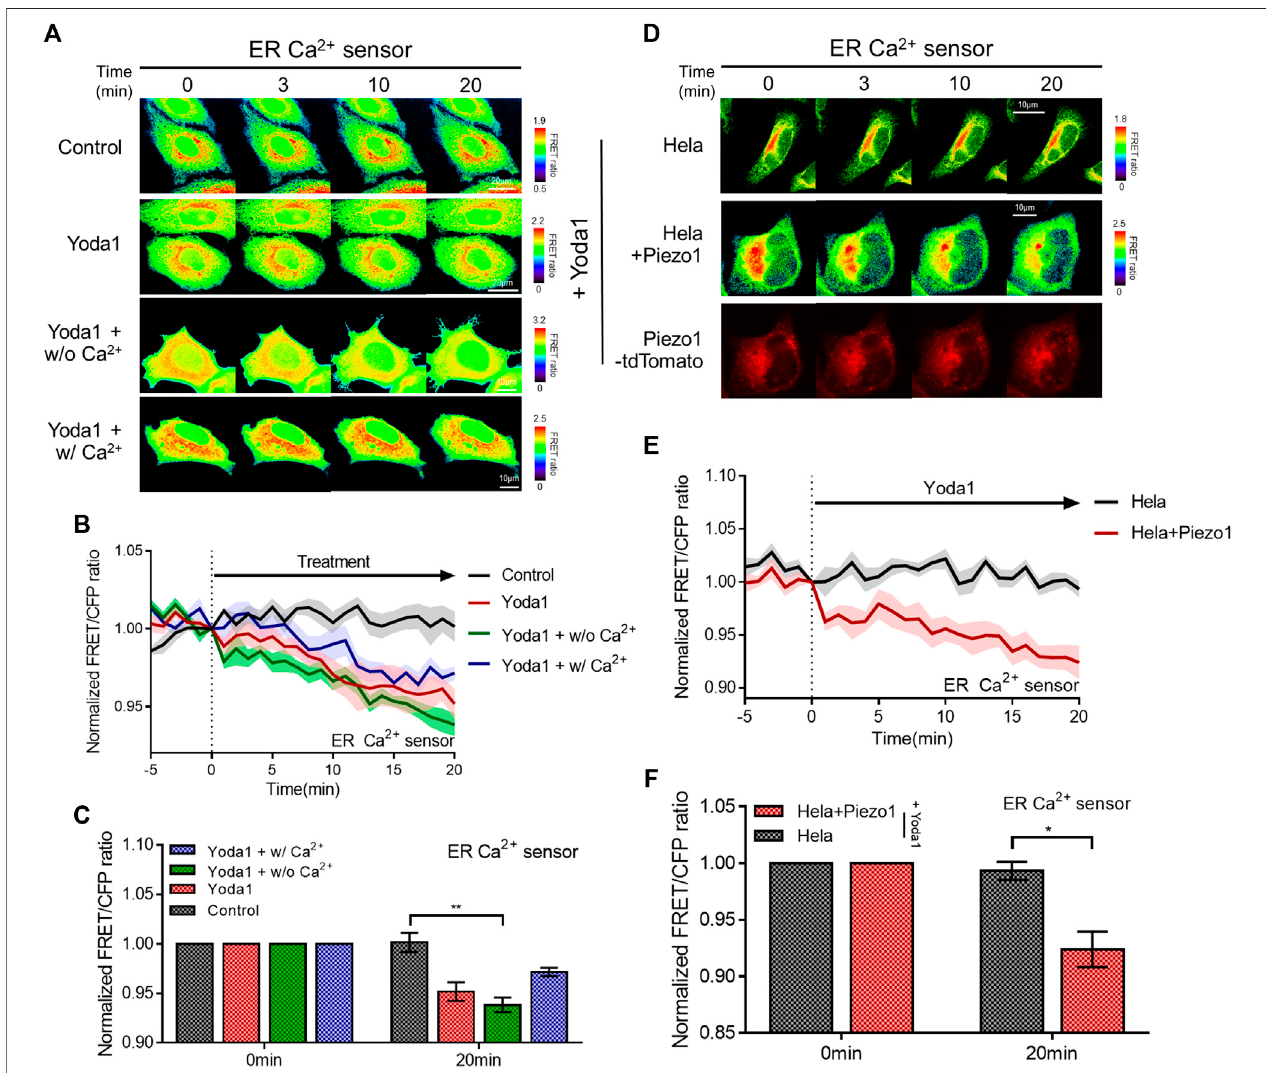
FIGURE 3 | Piezo1-dependent ER-stored Ca 2+ release in response to Yoda1. (A,D) Time-lapse FRET images of the ER Ca 2+ sensor in (A) MCF-7 and (D) HeLa cells.Thecellswereexposedtocontrol[0.2%(v/v)DMSO]andYoda1(1 μ M)dissolvedinCO 2 -independentculturemedium(Yoda1group),Ca 2+ -freemedium(Yoda1+ w/oCa 2+ group),andCa 2+ medium(Yoda1+w/Ca 2+ group),respectively.ThecolorscalebarsrepresenttherangeoftheFRET/CFPemissionratiodeterminedusingthe biosensor. Hot and cold colors indicate high and low Ca 2+ concentration, respectively. (D) The red fl uorescence protein images con fi rmed the expression of Piezo1-tdTomato. (B,E) ThetimecoursesrepresenttheaverageofthenormalizedFRET/CFPemissionratiochangesoftheERCa 2+ sensor.Thelinesaremeanvaluesof the normalized emission ratios, with diluted colors indicating the S.E.M ( n = 7). (C,F) The bar graph describes the mean values of the normalized FRET/CFP emission ratios of the ER Ca 2+ sensor at the described time with error bars indicating the S.E.M ( n = 7, * p < 0.05 and ** p < 0.01, Student ’ s t -test).